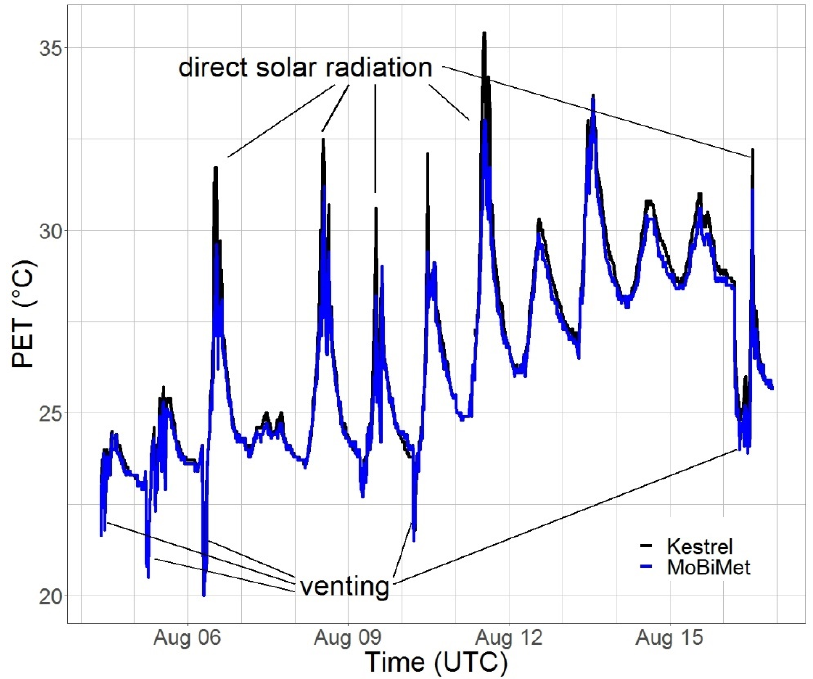
Figure 6. Physiologically equivalent temperature (PET) (°C) measured by a Kestrel 5400 Heat Stress Tracker (black) and a MoBiMet (blue) in an office in the city center of Freiburg between 4 August and 17 August 2021.